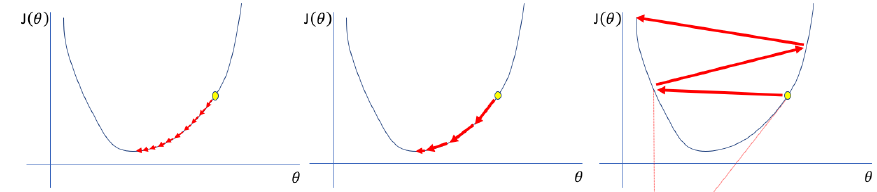
Figure B2. Learning rates that are too small, good, and too large from left to right (after Jordan,